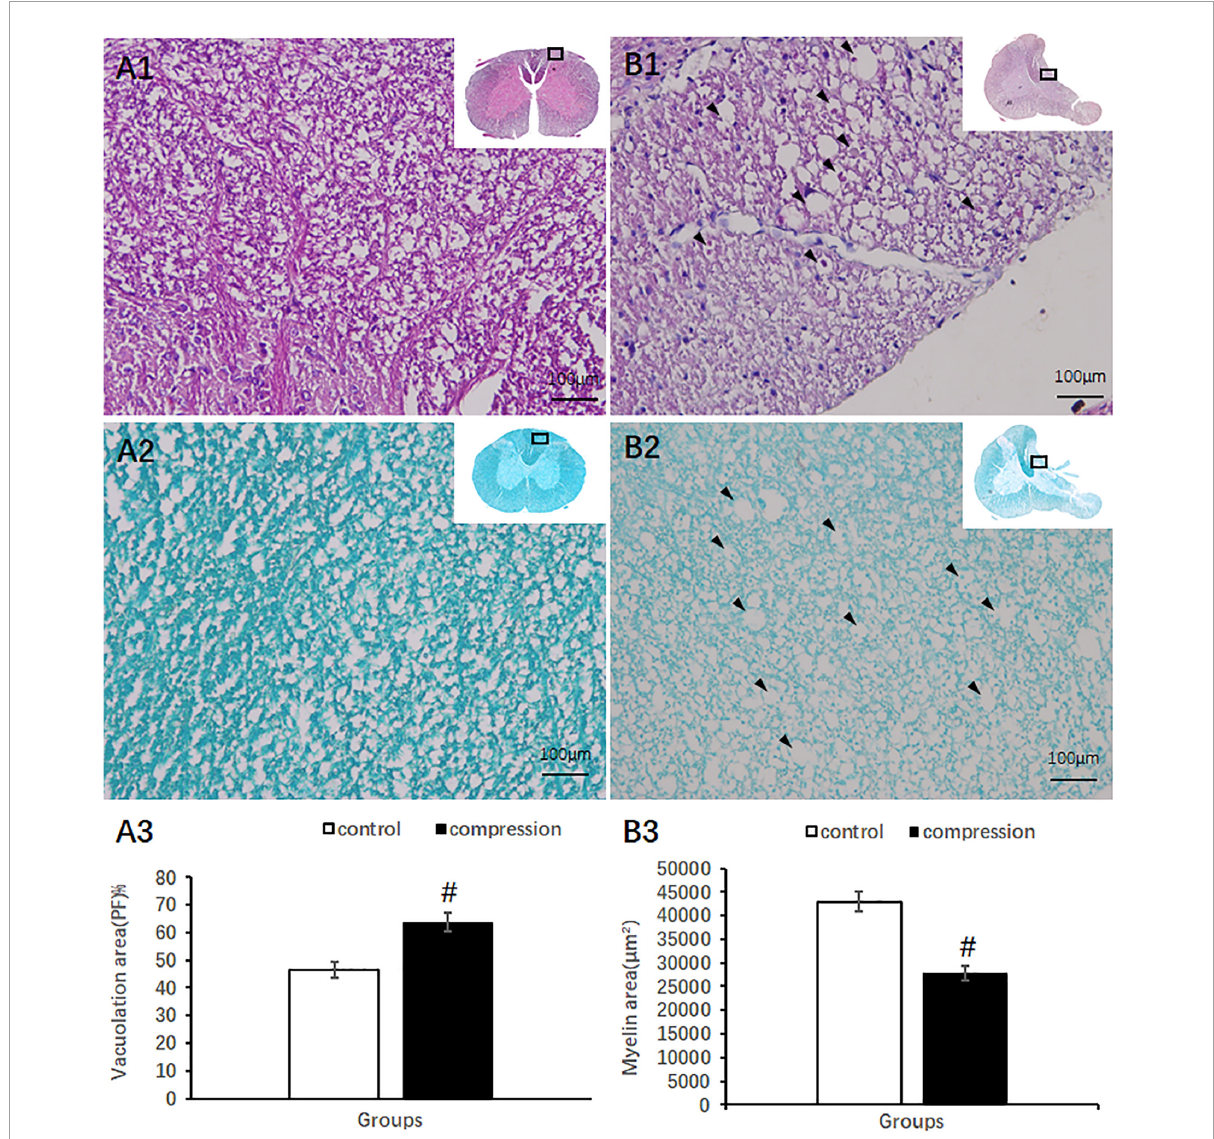
FIGURE4 Axonal degeneration in the posterior funiculus after compression revealed by HE and LFB staining. Organized neural fiber derived from the dorsal horn ( A1 , HE staining) and myelin sheath stained in dark blue in the control group ( A2 , LFB staining). (B1,B2) Vacuoles formation and a decrease in myelin staining in the posterior funiculus of the CSM group. Vacuolation area increased (A3) and myelin area decreased (B3) significantly in the CSM group ( P < 0.05, marked with “#” n = 6 per